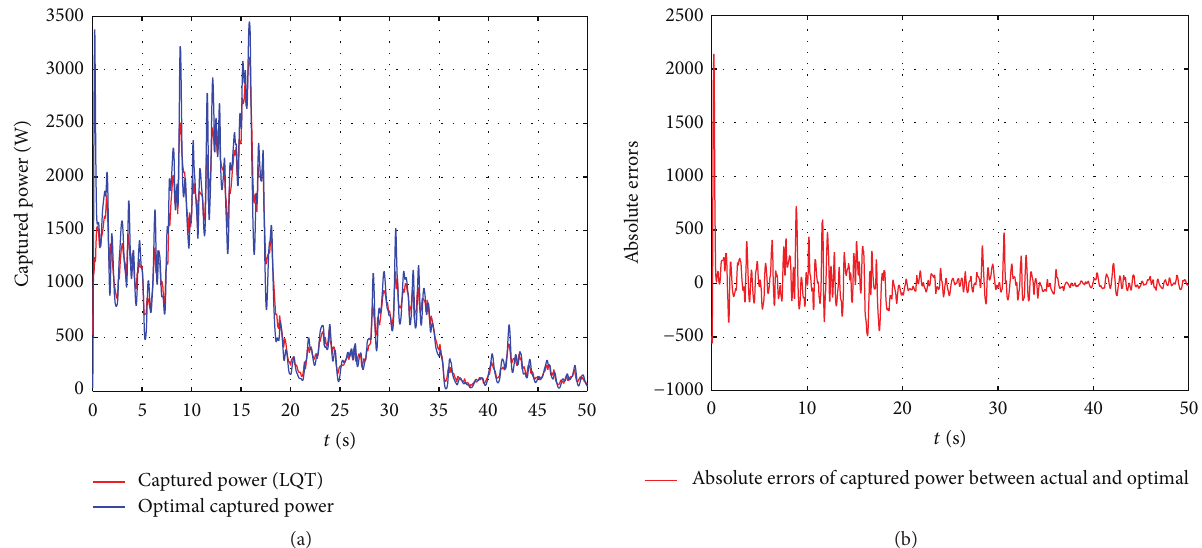
Figure 13: Captured power using optimal LQT control and the absolute